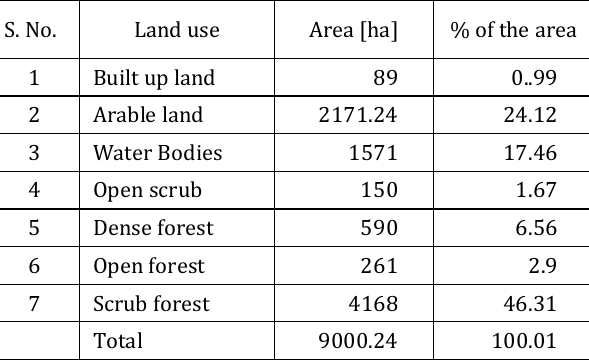
Table 4. LULC of submergence area (EIA/EMP